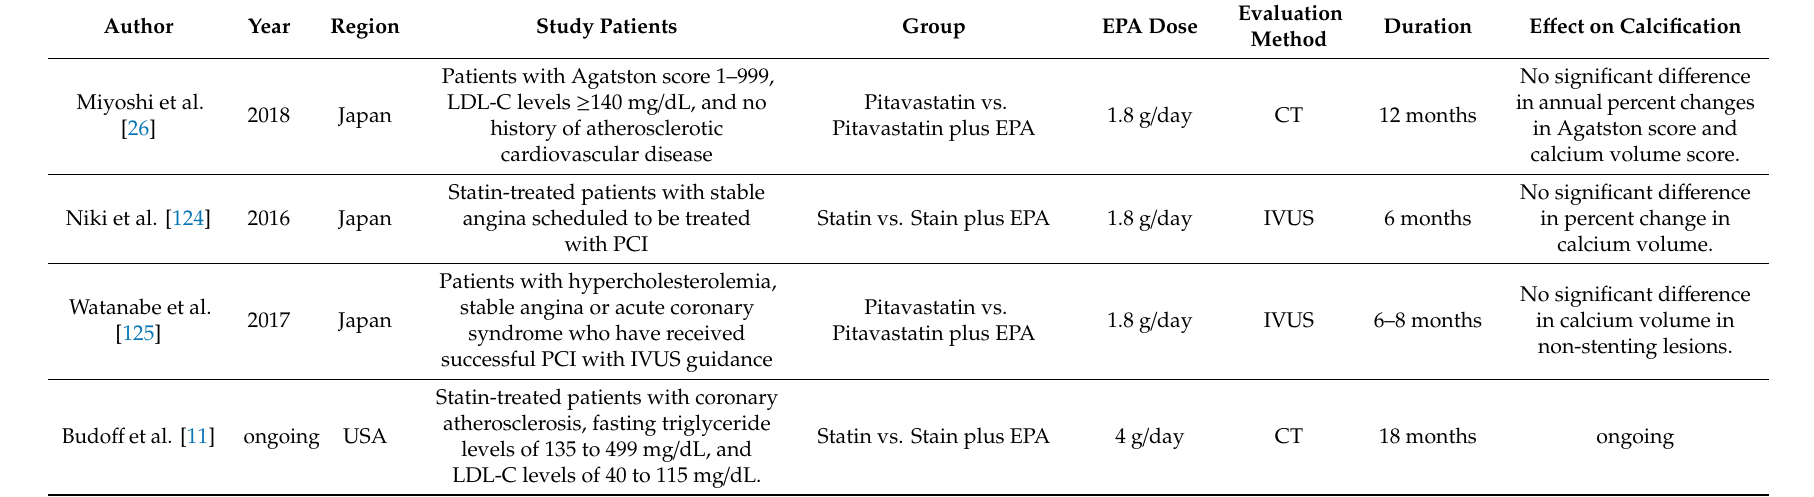
Table 2. E ff ects of EPA on Arterial Calcification in Clinical